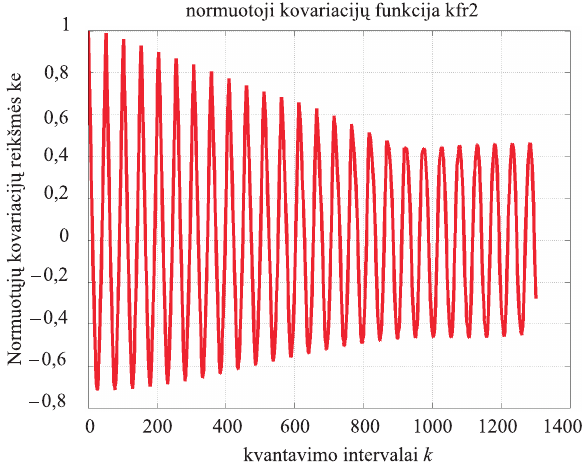
Fig. 5. Graphical view of the normalised auto-covariance function of the fragment of the magnetic resonance view of the damaged human brains by moving quantation interval